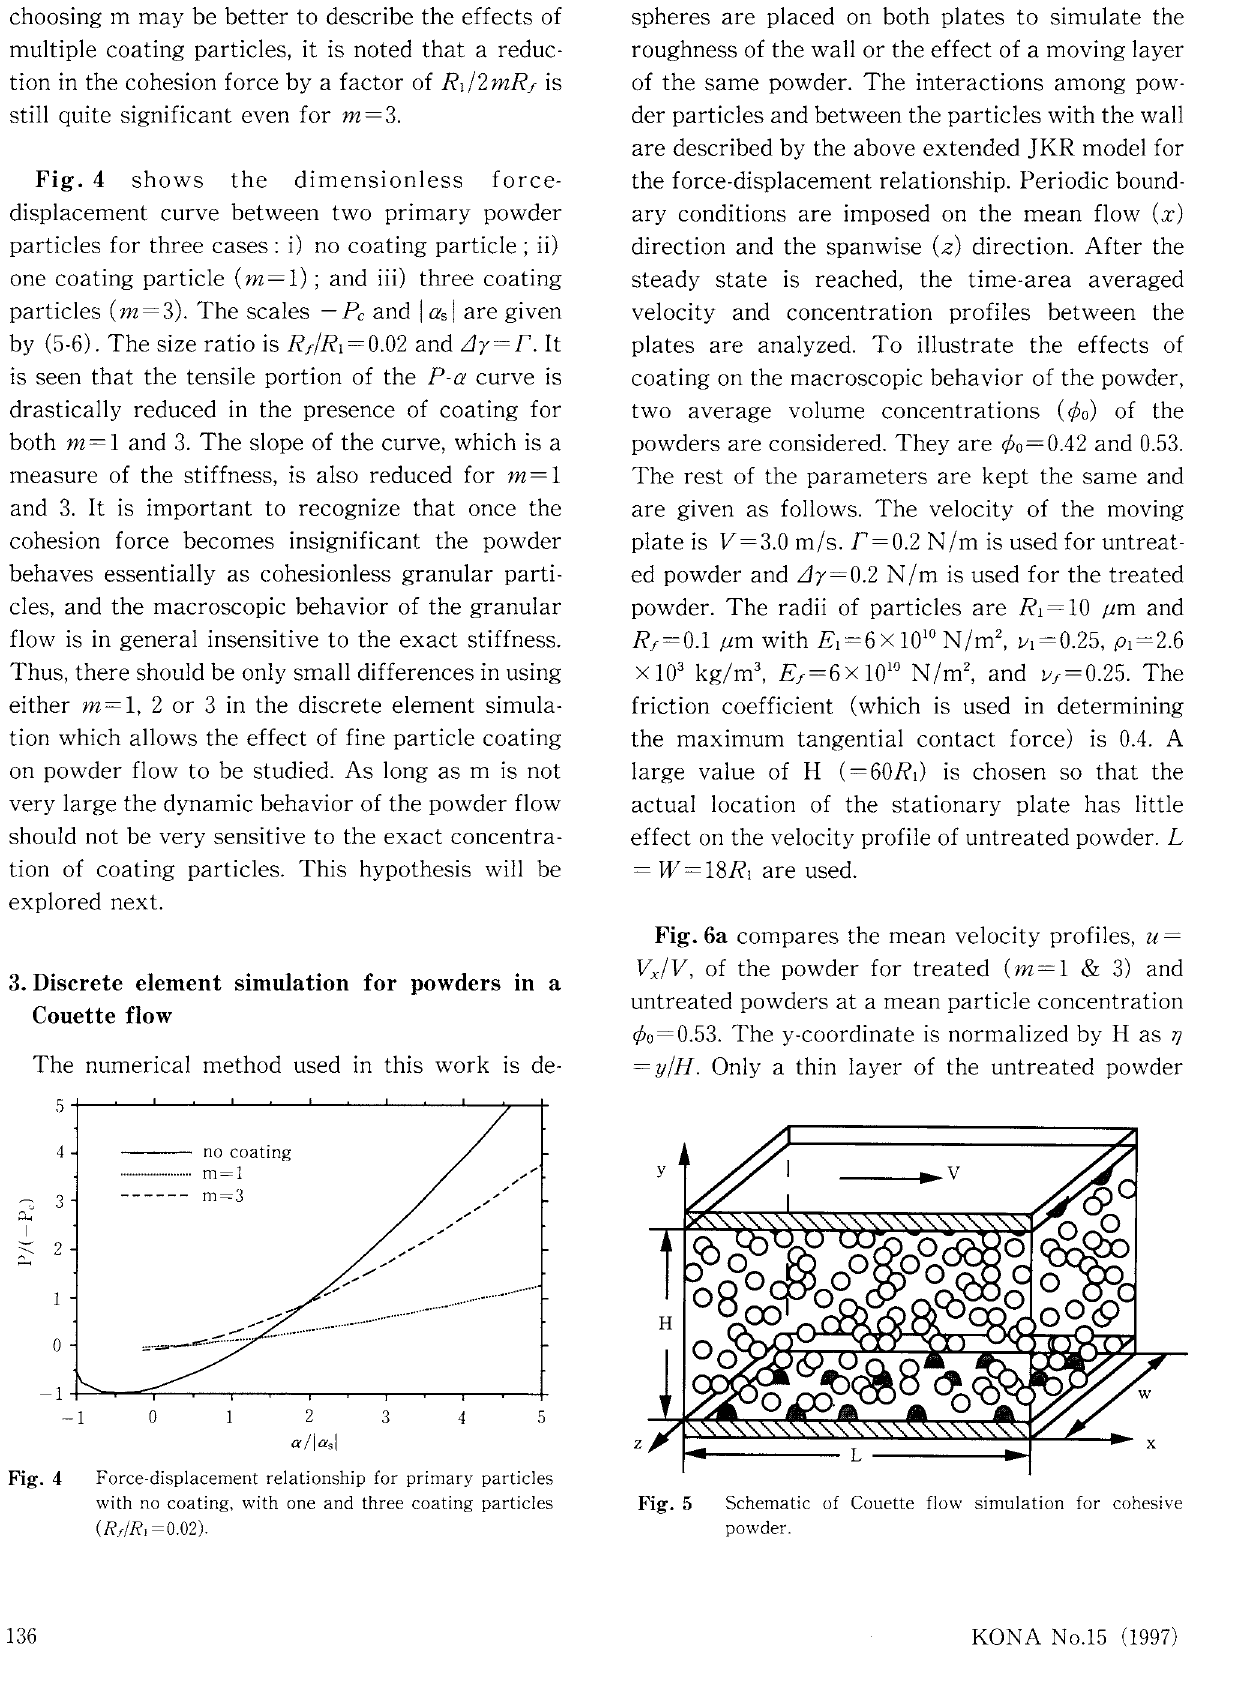
Force-displacement relationship for primary particles with no coating, with one and three coating particles (R 1 /R, =0.02).